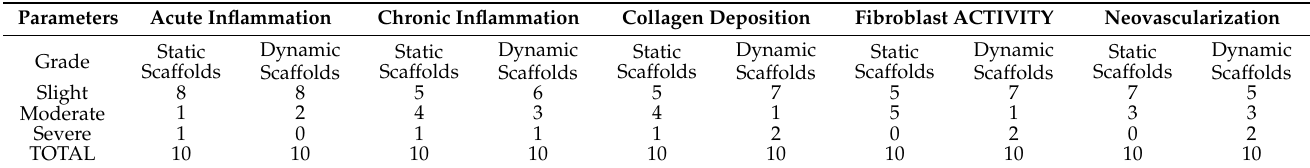
Table 2. Summary of the different parameters measured during the biological evaluation of the static and dy- namic PCL/elastin scaffolds: acute inflammation, chronic inflammation, collagen deposition, fibroblast activity and neovascularization.